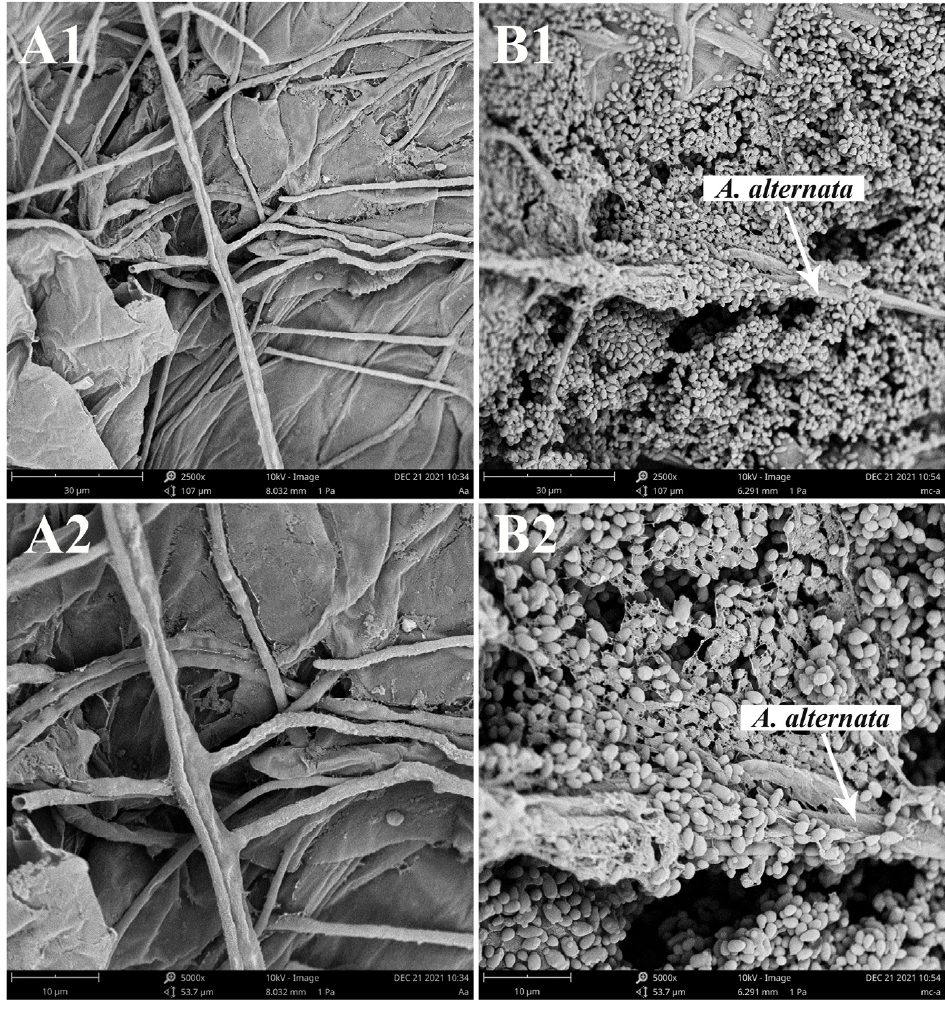
Figure 3. SEM of jujube wound tissues 48 h after inoculation. Wounds were incubated with ( A ) A. alternata , ( B ) M. caribbica, and A. alternata ; ( A1 , B1 ): magnification of 2500×; ( A2 , B2 ): magnification of 5000×.